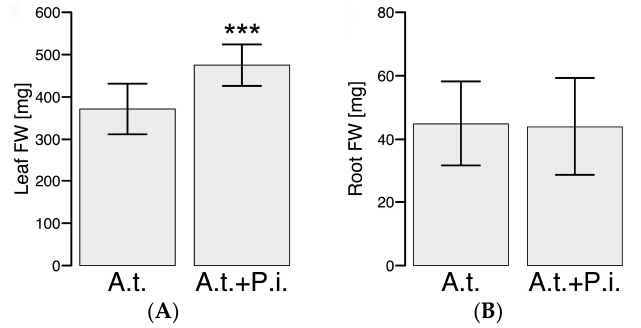
Figure 1. Leaf and root fresh weight of A. thaliana (A.t.) after co-cultivation with P. indica (P.i.) in a